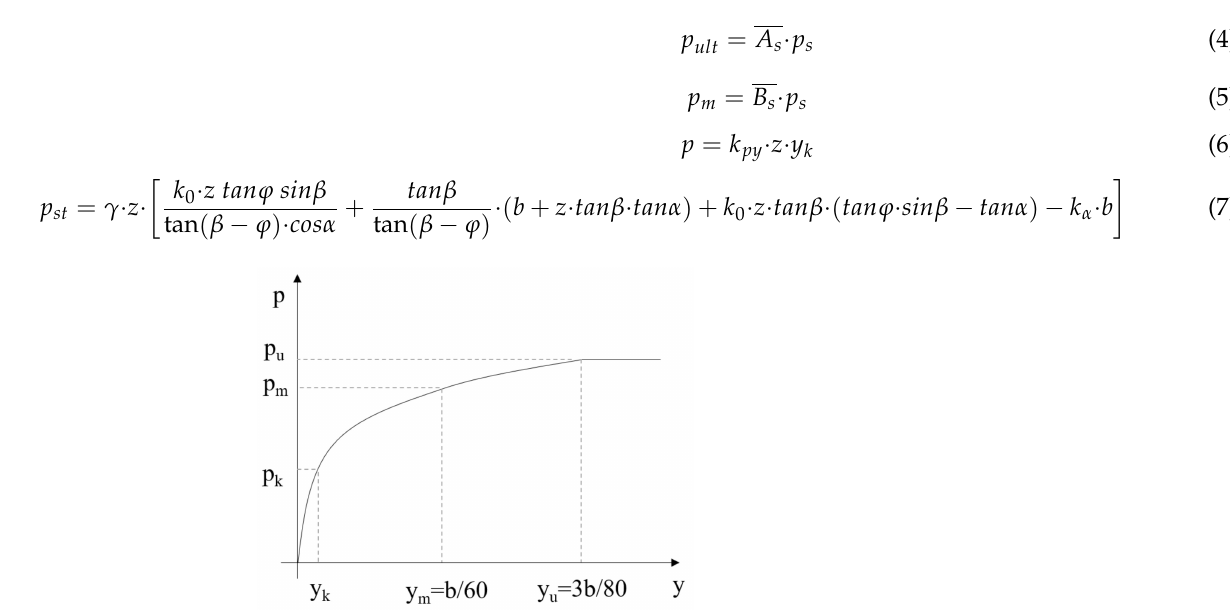
Figure 3. Backbone curve